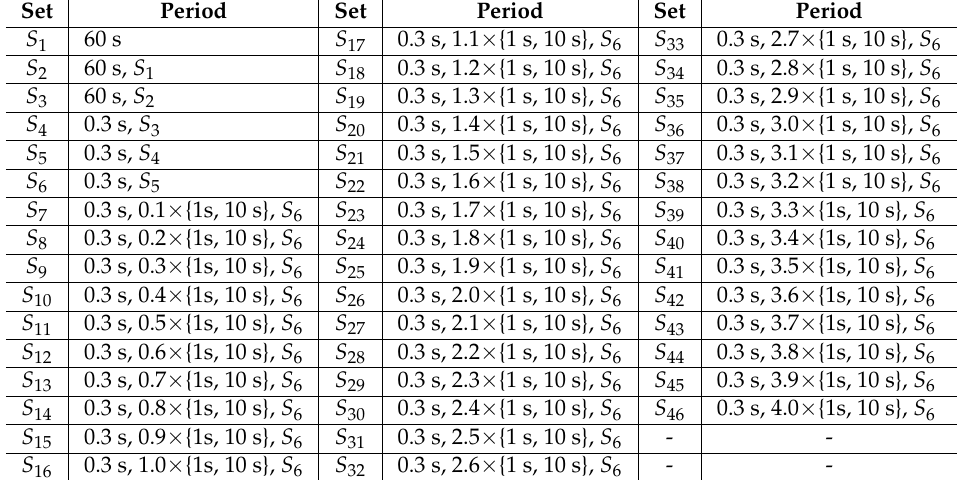
Table 5. Scenario 3 evaluation SmartData